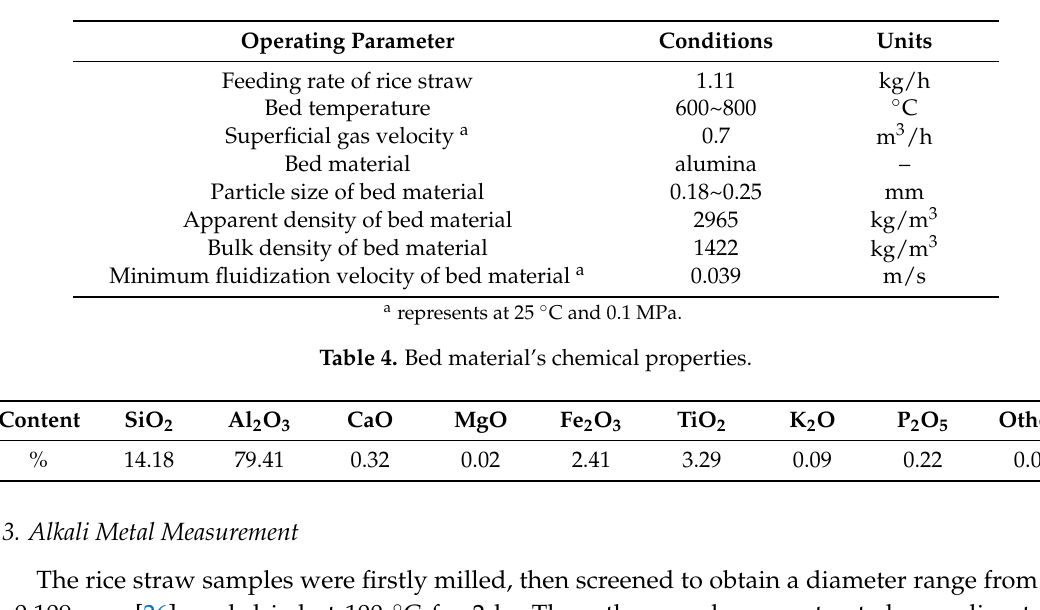
Figure 1. Biomass gasification fluidized bed experimental system. PID, Proportion-Integral-Derivative. Table 3. Operating conditions.